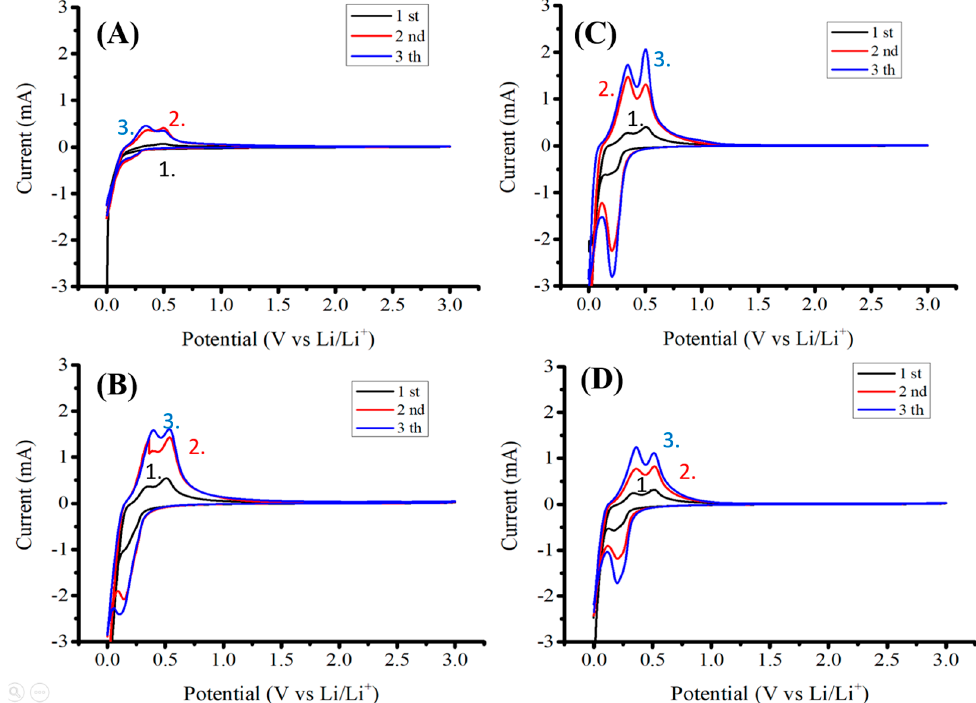
Figure 5. Cyclic voltammetry of anodes made of ( A ) silicon flakes:Super P:CMC/SBR = 70%:10%:20% by